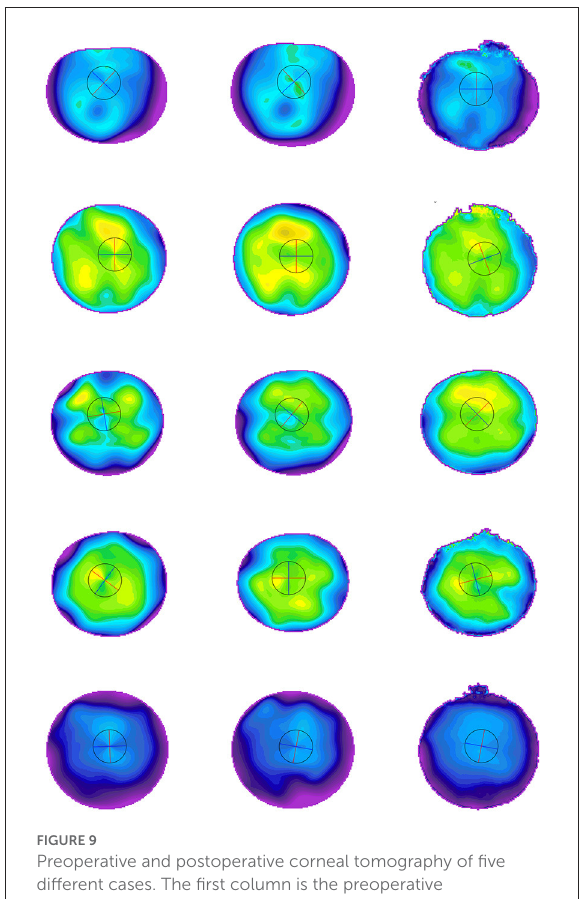
FIGURE9 Preoperative and postoperative corneal tomography of five different cases. The first column is the preoperative corneal tomography, the middle is the real postoperative corneal tomography, and the last column is the synthetic corneal